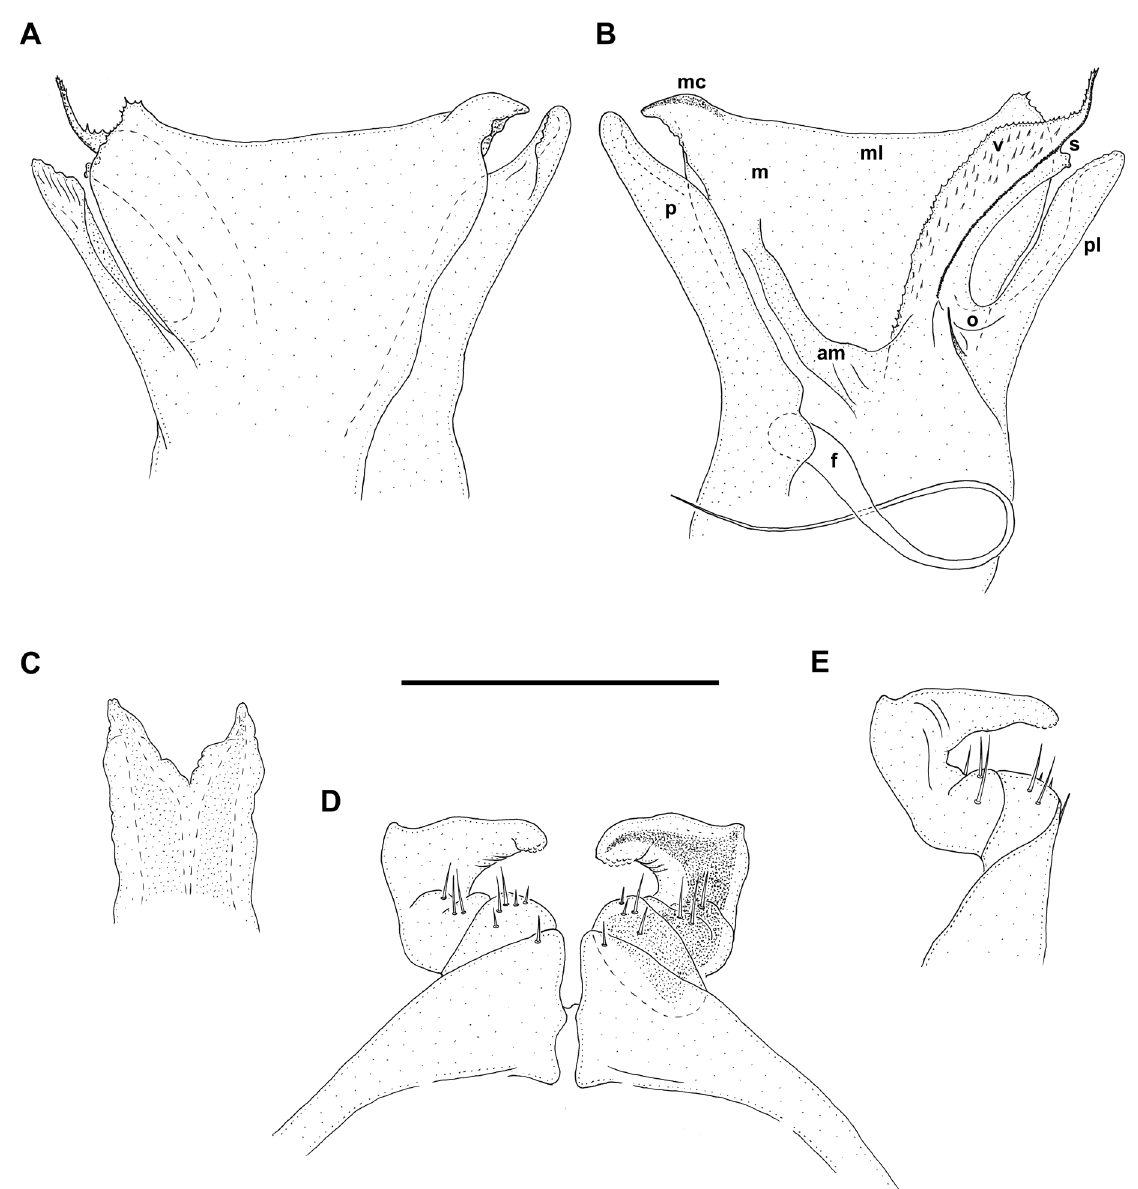
Fig. 31. Leucogeorgia oculata sp. nov., paratype ♂ from Lagonaki Plateau (ZMUM). A . Left gonopods, lateral view. B . Left gonopods, mesal view. C . Penes, posterior view. D . Leg-pair 1, anterior view. E . Left leg 1, lateral view. Abbreviations: am = accessory membrane; f = flagellum; m = mesomere; mc = mesomeral claw; ml = mesomeral lamella; o = opisthomere; p = promere; pl = protective lamella; s = solenomere; v = velum. Scale bar: 0.2